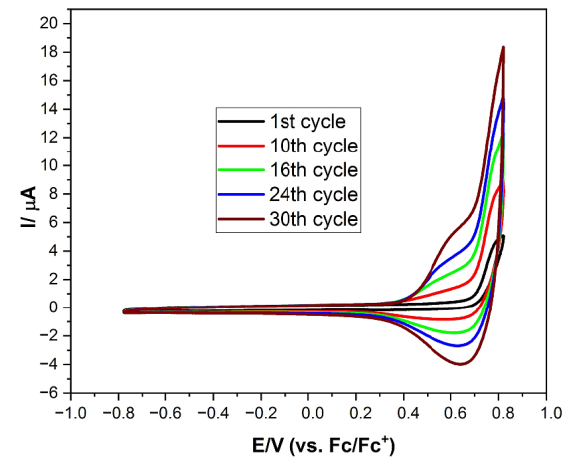
Figure 6. Voltammograms of polymerization of M3 carried out potentiodynamically with upper potential as high as 0.82 V, with sweep rate ν = 100 mV/s, 0.1 M Bu 4 NPF 6 in CH 2 Cl 2 .